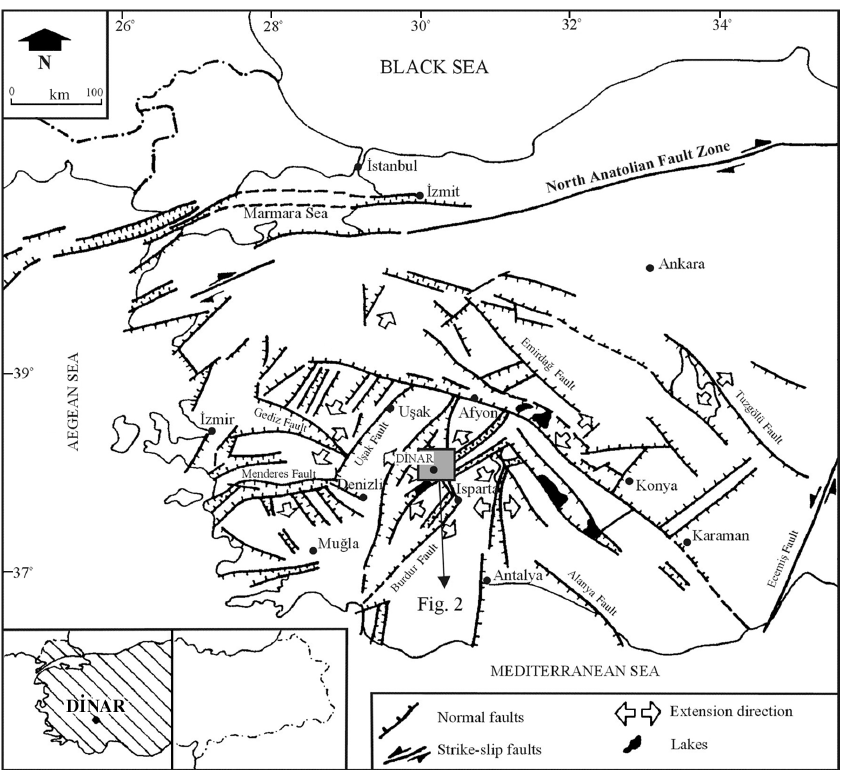
Fig. 1. Simplified tectonics map of Western Turkey (adapted from Kocyigit, 1984). The square indicates the area in fig.